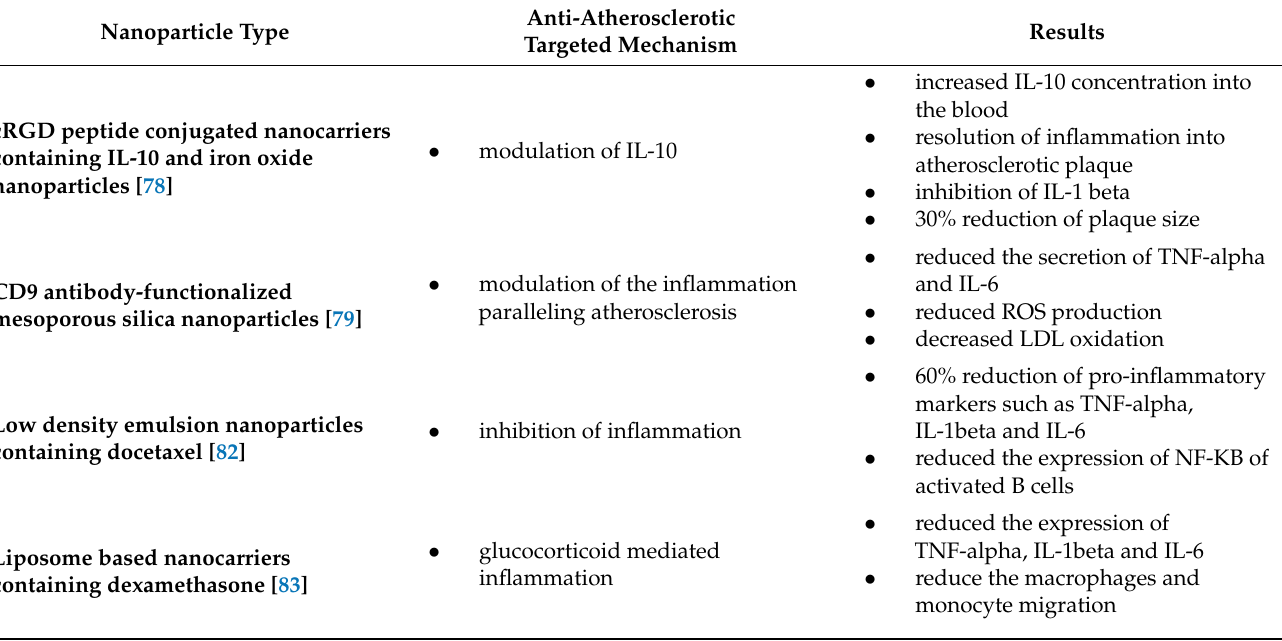
Table 4. Nanoparticles targeting pro-inflammatory